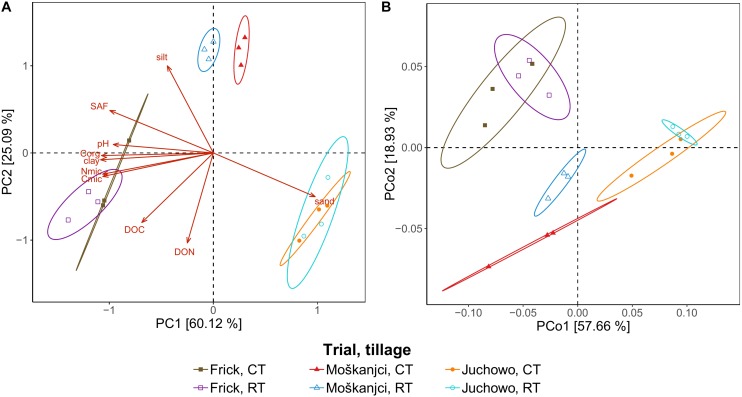
PCA of soil parameters (A), and PCoA based on Bray-Curtis distances depicting taxonomic profiles of bacteria at the family level (B). Ellipses drawn around triplicates represent a 95% confidence level.